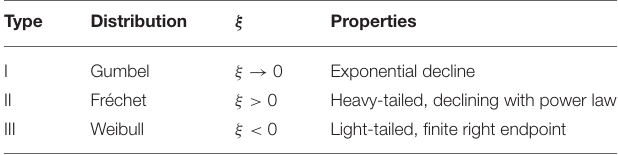
TABLE 1 | Summary of the EDVs and their linking to